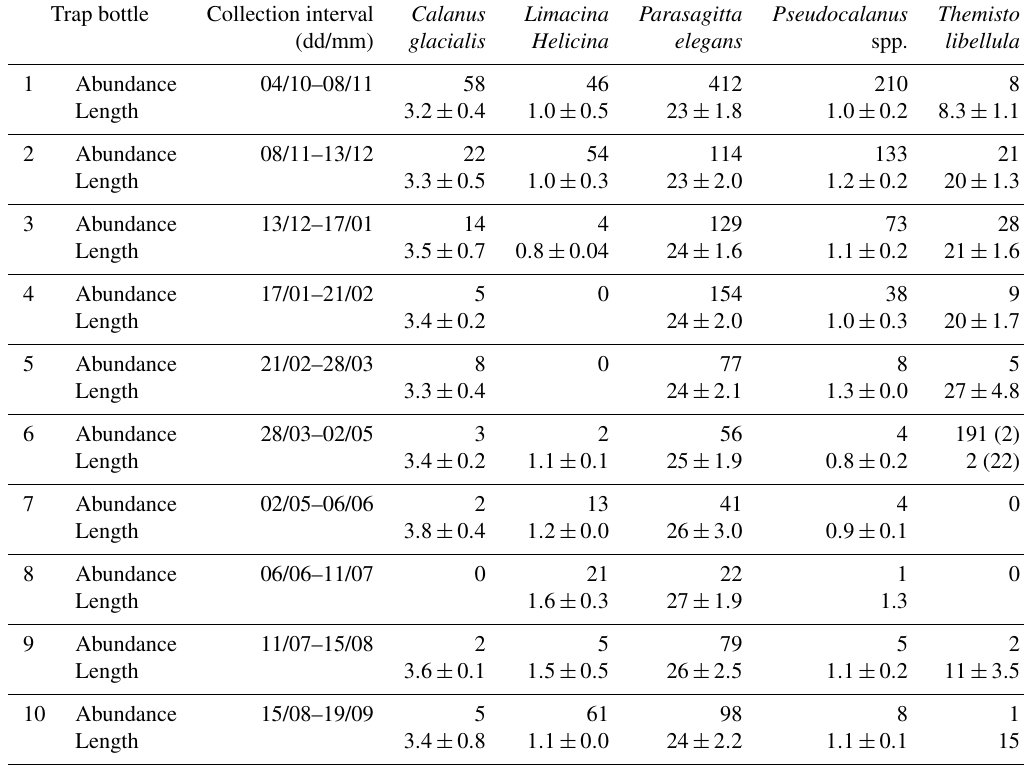
Table 1. Abundance (ind . m − 3 ) and length (mm) of the dominant zooplankton ( > 500µm) in each bottle of the sediment trap at AN01 from October 2016 to August 2017. Note: T. libellula juveniles and adults are presented separately for bottle 6; adult abundance and length are in parentheses.